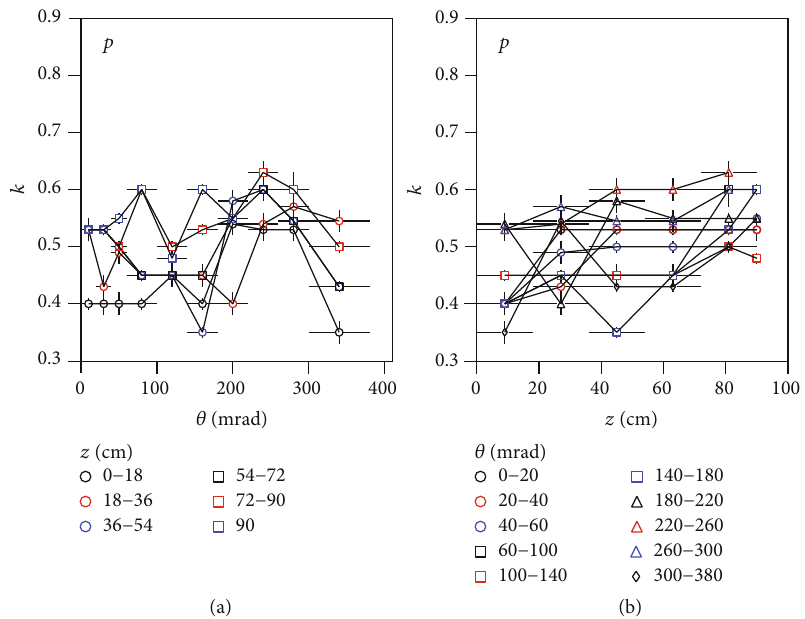
Figure 11: Dependence of k on (a) θ and (b) z , which are extracted from the data samples within di ff erent z and θ ranges,